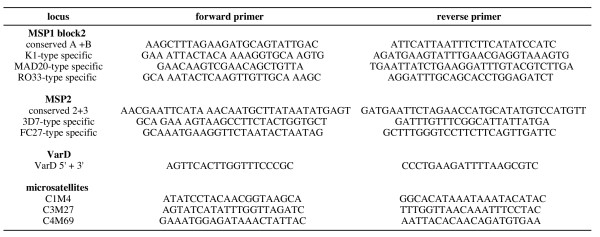
Sequence of primers.